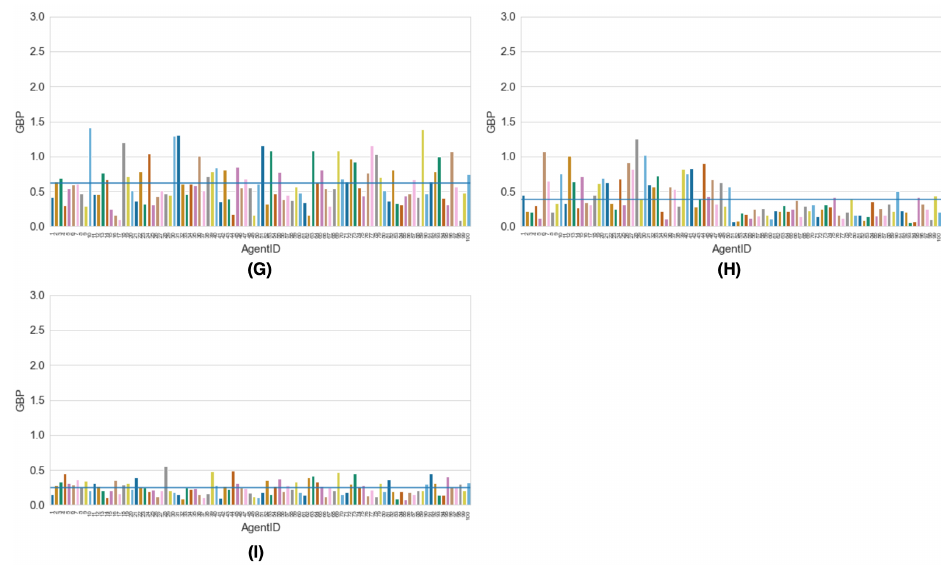
Figure A3. The total sum of electric costs (GBP) for each PHEV, model conditions 7 to 9.